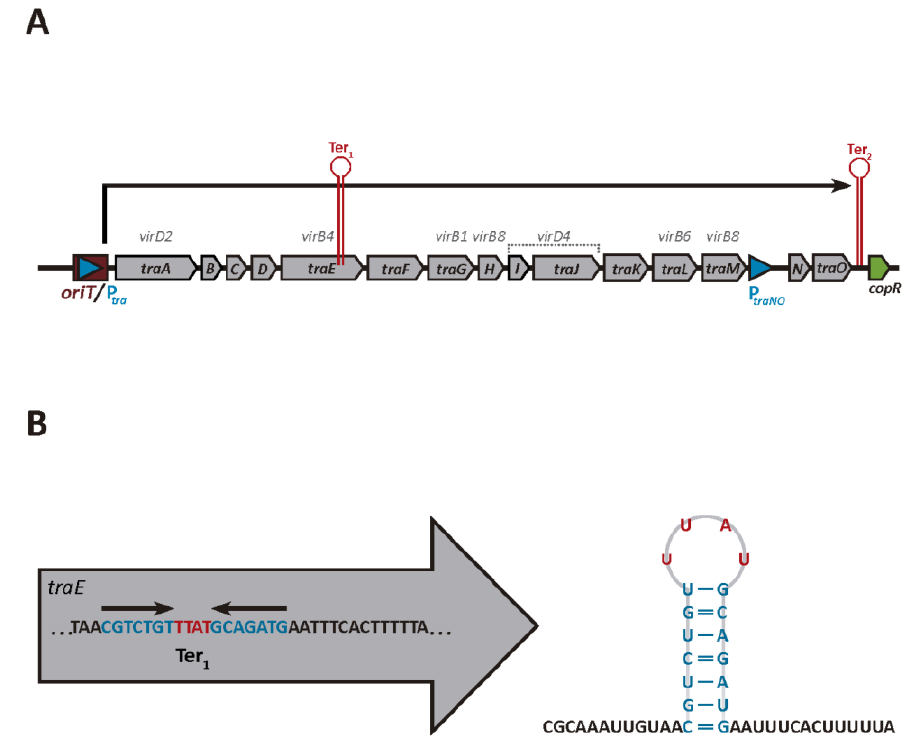
Figure 1. Features of the conjugation operon of plasmid pIP501. ( A ) Schematic genetic map of the pIP501 conjugation operon. Genes are indicated with arrows. The positions of the putative terminators Ter1 and Ter2 are indicated with red lollipops. oriT = origin of transfer. The conjugation promoter P tra is followed by traA , the first gene in the operon. The functions of the following tra genes are known: traA (relaxase), traE (ATPase), traG (lytic transglycosylase), traH (secretion channel protein), traI and - J (coupling protein), traL (secretion channel protein), traM (secretion channel protein), traN (repressor). ( B ) Schematic view of the putative terminator Ter1 located within the traE gene. Part of the traE sequence encompassing the putative intrinsic terminator is shown. Inverted repeat sequences and the nucleotides separating them are given in blue and red, respectively (left panel). The stem loop structure predicted to be formed when this region is transcribed into RNA is shown on the right using the same color code as in the left